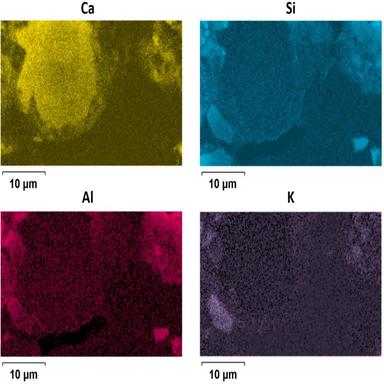
EDS mapping images displaying major chemical elements (Ca, Si, Al, K) present within and surrounding the coated particle.